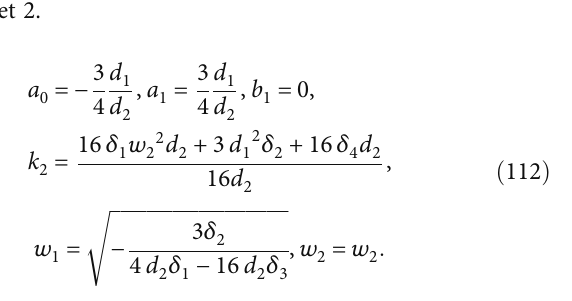
Figure 11: The graphical simulation representation of j U 11 δ = 0 : 6, w = 0 : 01 4 2